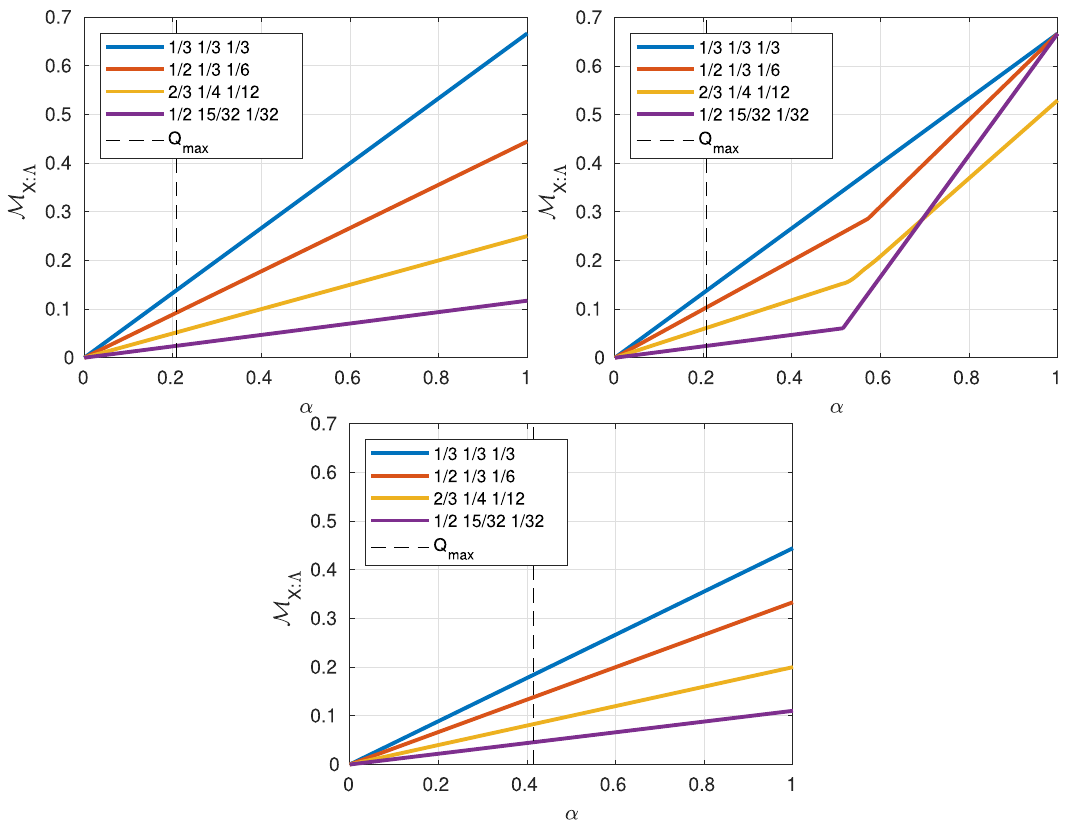
Figure 3: Measurement dependence X :Λ (cid:2) for violations α of instrumental inequality I 2 ( left ) , and causal bounds C 2 ( center ) and C 3 ( right ) . The maximal violation of each inequality attainable in quantum theory is marked by Q max ( Section 4 )